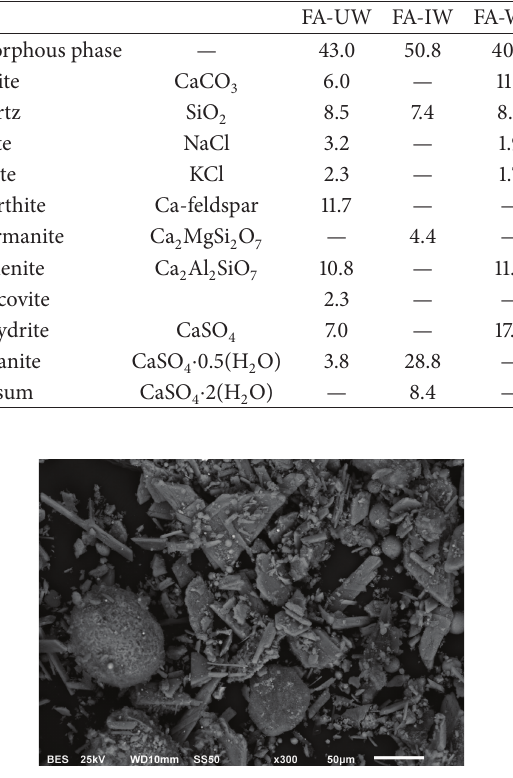
Figure 4: SEM image of treated FA-WW ash.